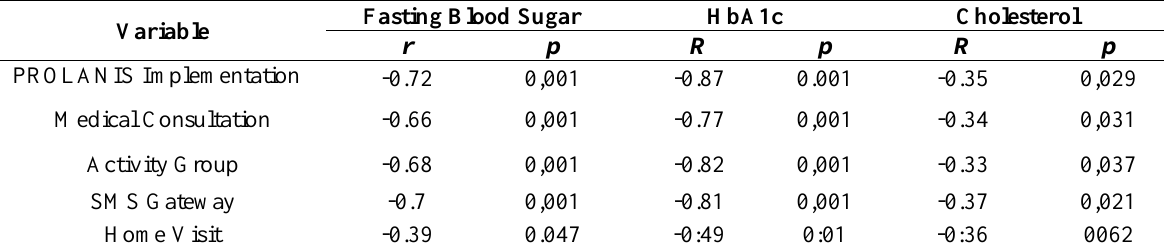
Table 3. Relationship of PROLANIS Implementation and Fasting Blood Sugar, HbA1c and Total Cholesterol in Patients with Type 2 Diabetes Mellitus